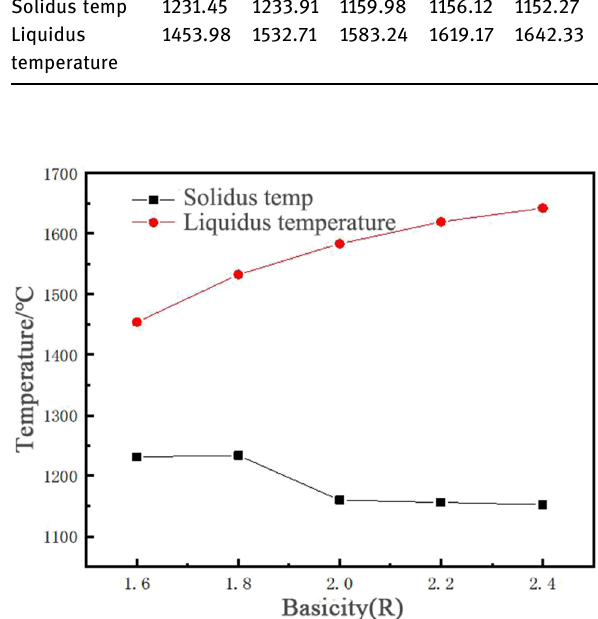
Figure 8: Melting temperature of mixed slag samples with variable